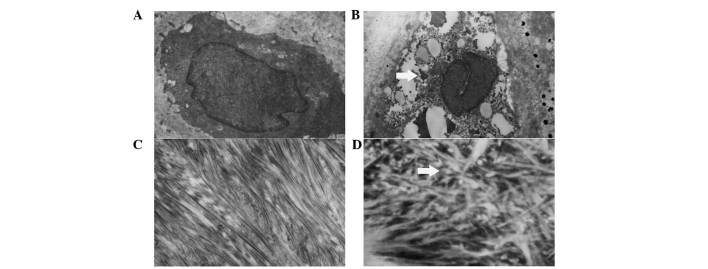
The ultrastructure of the disc by scanning electron microscopy (SEM). (A) and (C) show the ultrastructure of the apparently normal disc at 12 weeks in the control group. (B) and (D) show the poor the performance of the discs in the DM group at 12 weeks. The arrow in (B) shows swelled organelles and incomplete nucleus. The arrow in (D) shows that the fibers were in disarray. Original magnification, ×6,000.